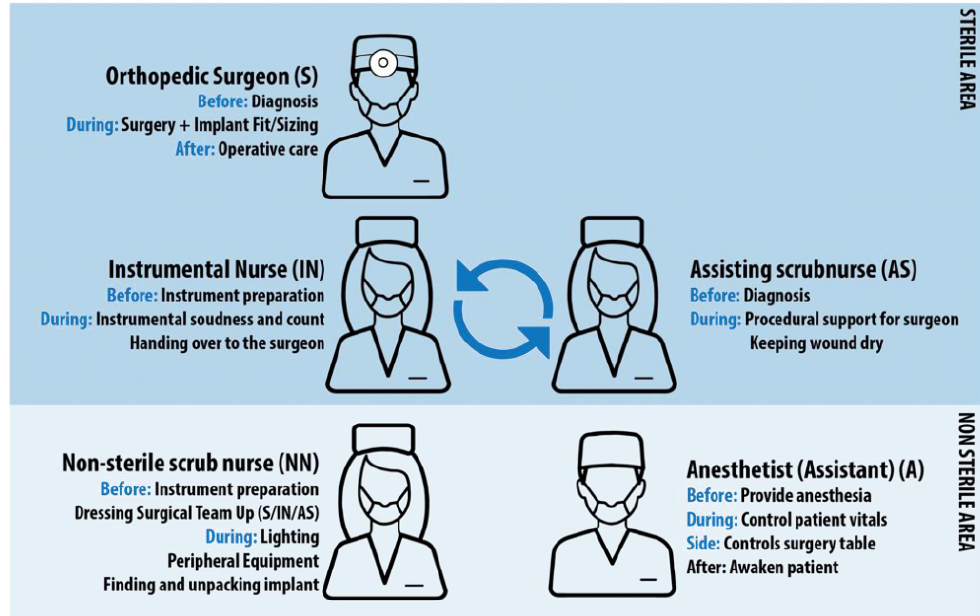
Figure 8. Task analysis of OR teams and their